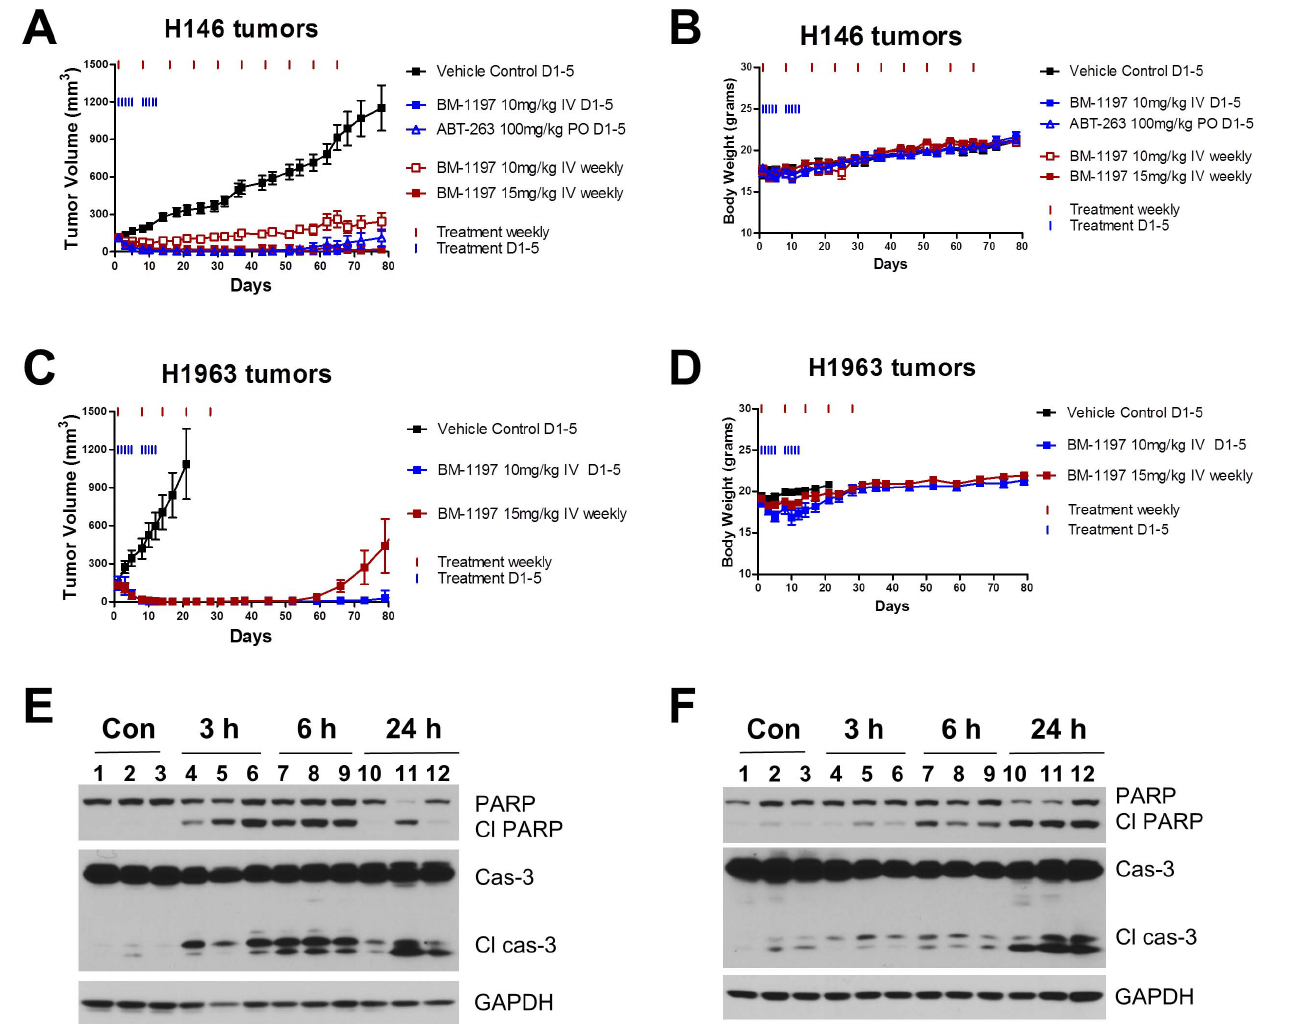
Figure 10. Invivo antitumor activity of BM-1197. (A–D) SCID mice bearing H146 or H1963 cells were treated with BM-1197 intravenously (IV) or ABT-263 orally (PO) at the indicated dosing schedules, and tumor volumes and body weights were measured every 2–3 days. Data shown are mean 6 SEM for 6–8 mice. (E & F) SCID mice bearing H146 or H1963 cells were treated with 10 mg/kg of BM-1197 IV for the indicated times. Tumor lysates were analyzed by